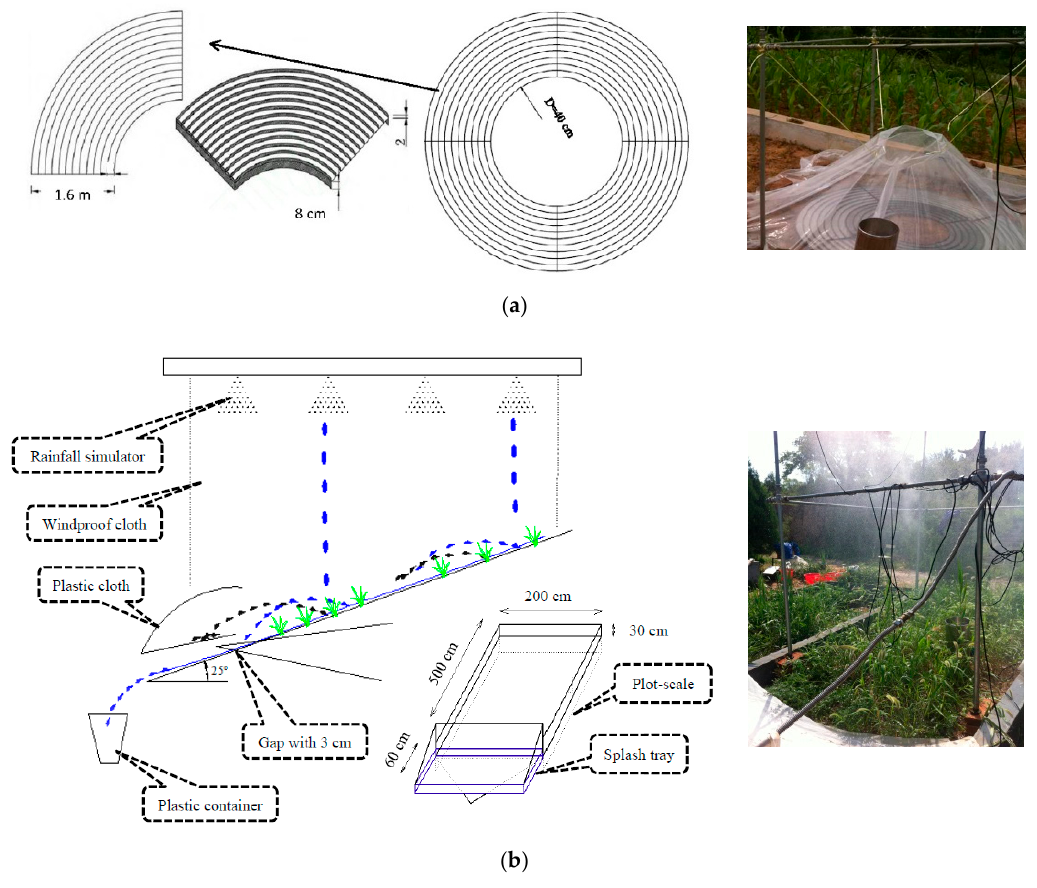
Figure 3. Diagram of the experimental setup: ( a ) schematic and dimensions of point-scale Experiment 1 for obtaining splashed particles and ( b ) view of plot-scale Experiment 2 for monitoring the characteristics of slope splash erosion.